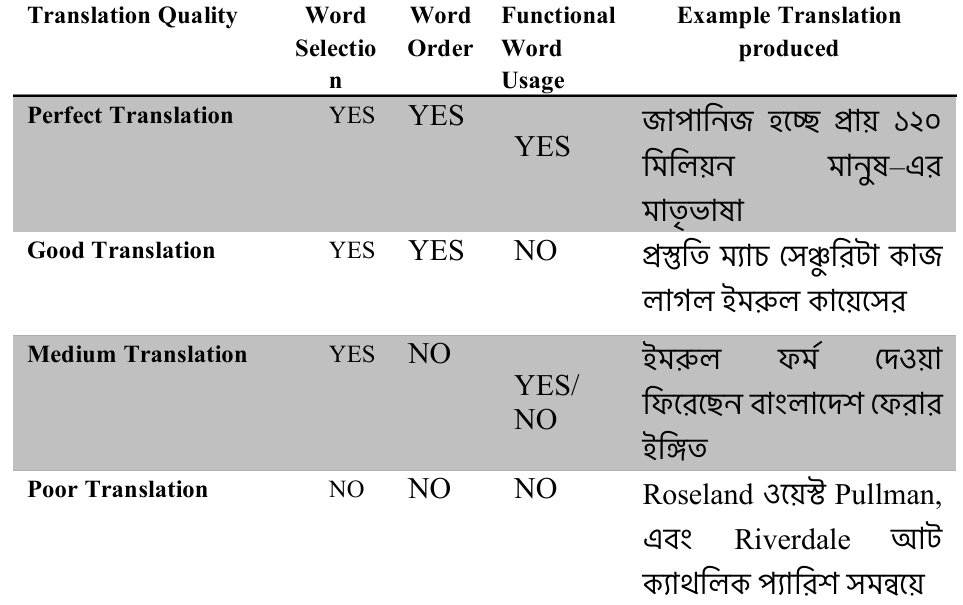
Table 9. Human Evaluation quality